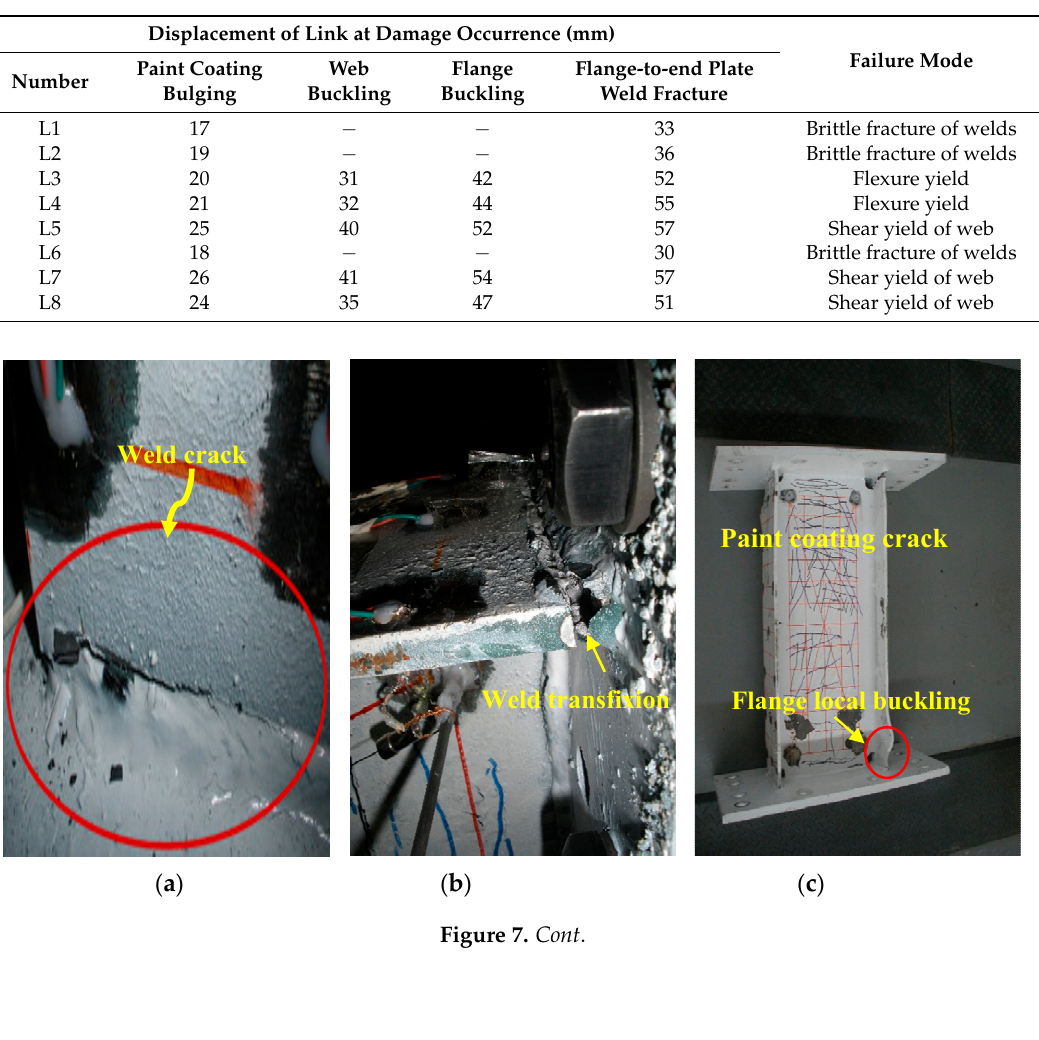
Table 3. Damage and failure process of specimens.